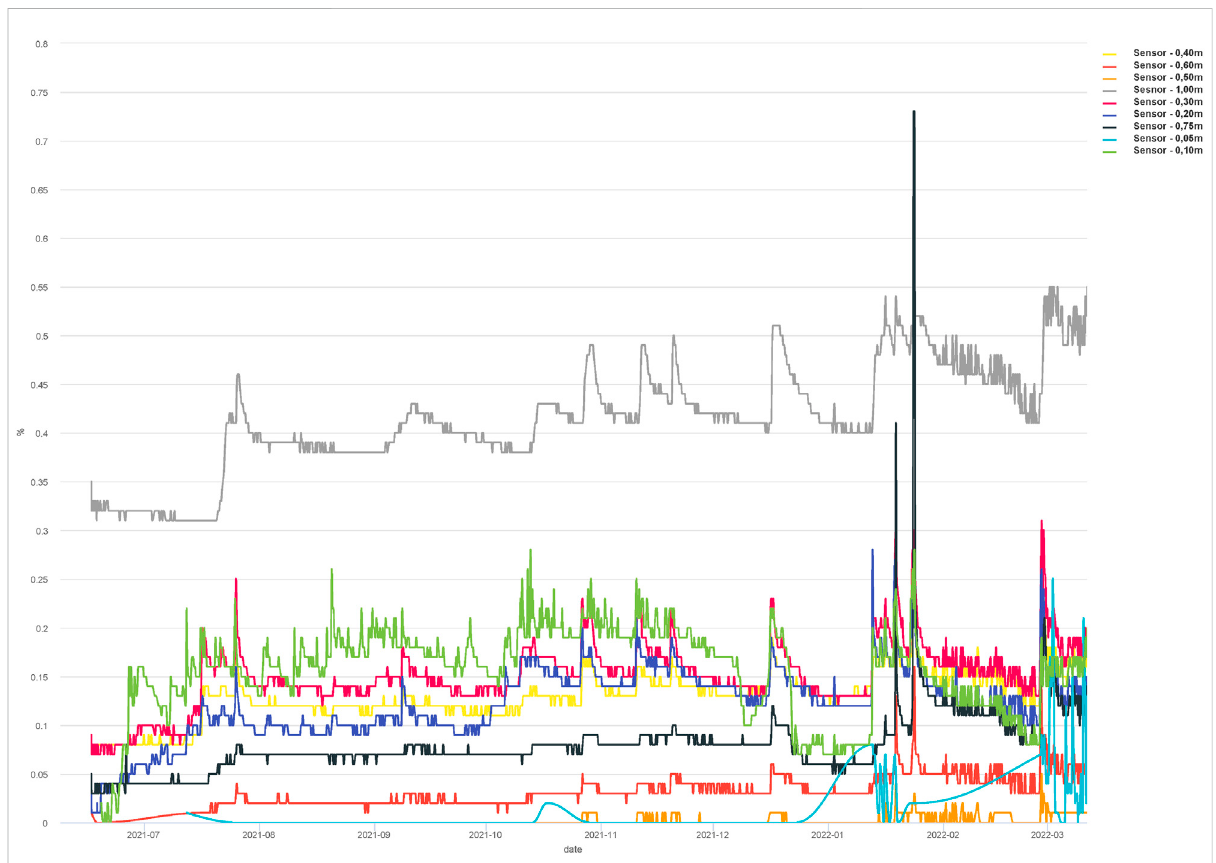
FIGURE 12 Sjåberget Andøya monitoring point, soil water content plot, from installation 8 June 2021 — 11 March 2022. Plot by Lars Krangnes, Cautus Geo, from CautusWeb